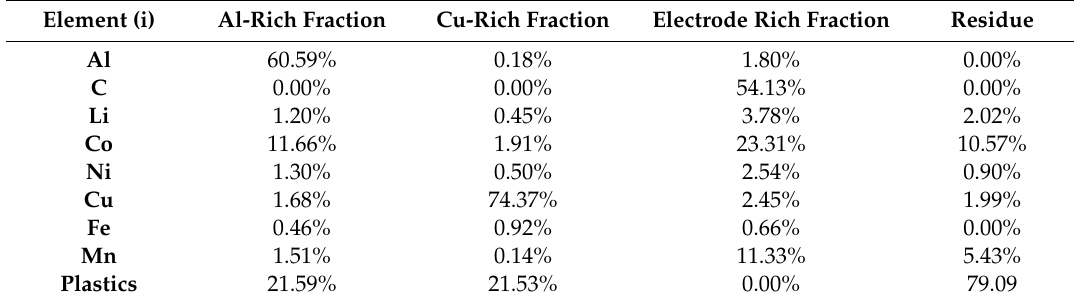
Table 1. Weight recoveries (wt%) of the Al, Cu, electrode, and residues obtained by the Aalto pre-processing (PP) [20].